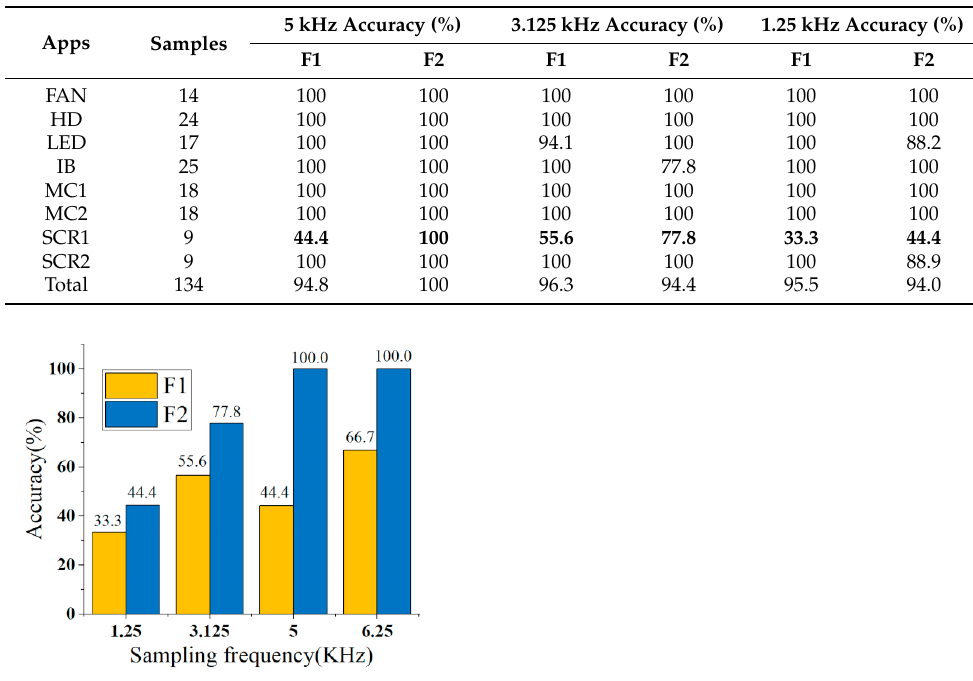
Figure 11. The effectiveness of overshoot multiple σ P . Table 8. Accuracies of the training set of a single